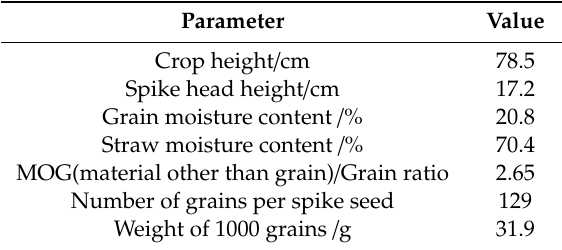
Table 2. Material characteristics of rice.